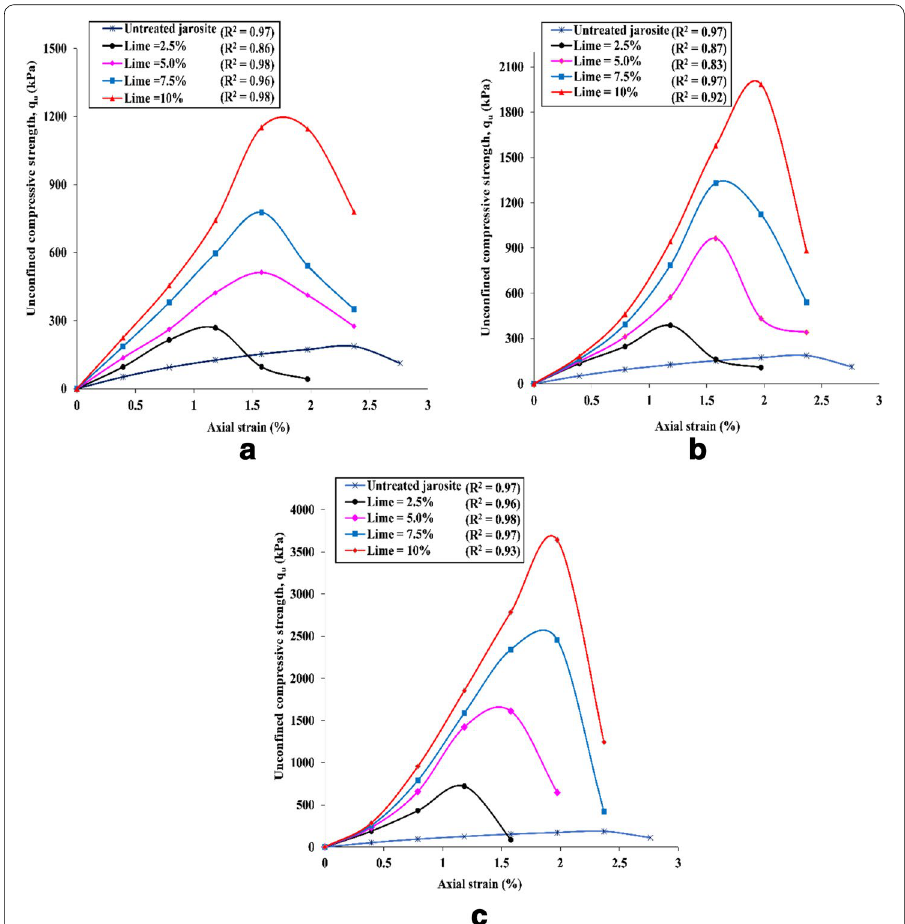
Fig. 4 Effect of lime content on Stress–Strain behaviour of UCS samples cured at a 7, b 28, and c 90